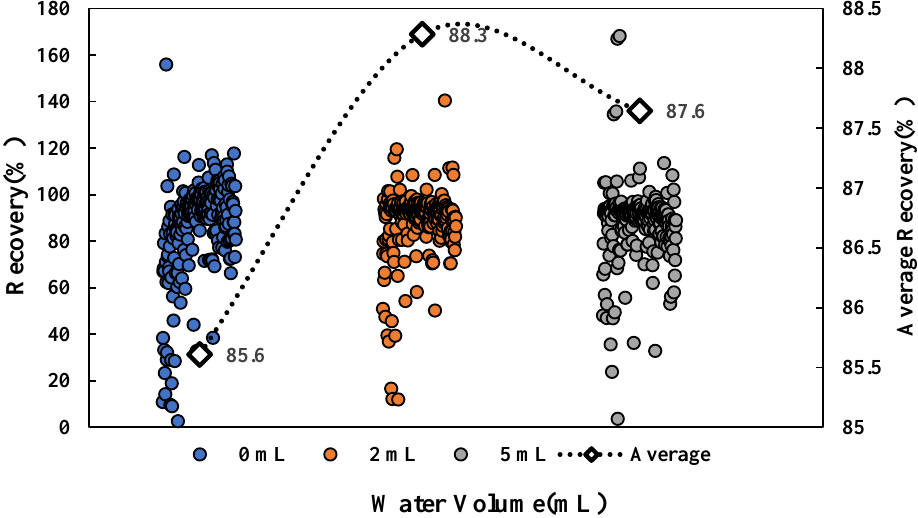
Figure 1. Effects of hydration volumes on pesticide recovery.